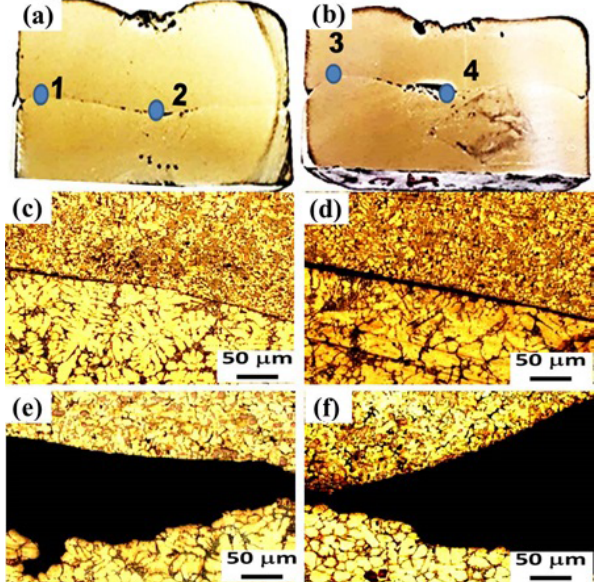
Figure 5. Macro- and microstructure of bimetal casting for 30 and 40s time intervals. (a) Macrophotograph cross section for a 30s time interval. (c, e) Representation of the microstructures of points 1 and 2, respectively. (b) Macrophotograph cross section for a 40s time interval. (d, f) /microstructures of points 3 and 4,